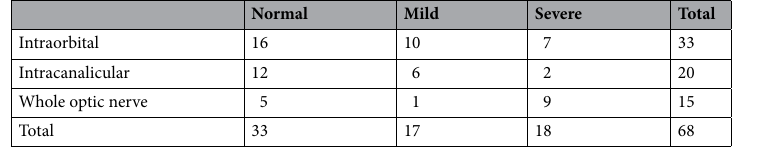
Table 3. Relationship between lesion location on MRI and optic disc swelling. Patients with lesions in the whole optic nerve tended to have severe optic disc swelling ( p = .023, Chi-square test).